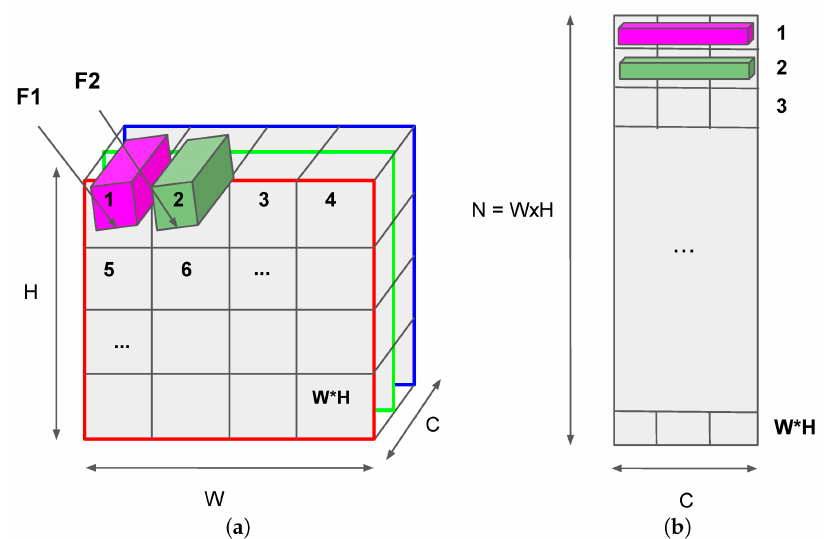
Figure 7. ( a ): Example showing how to compute the relationship, in the spatial dimensions, between pixels 1 and 2; it is the dot product of the two depicted volumes, each volume divided by the 2-norm. ( b ): Flattened version of the feature map to interpret a possible implementation of the similarity matrix